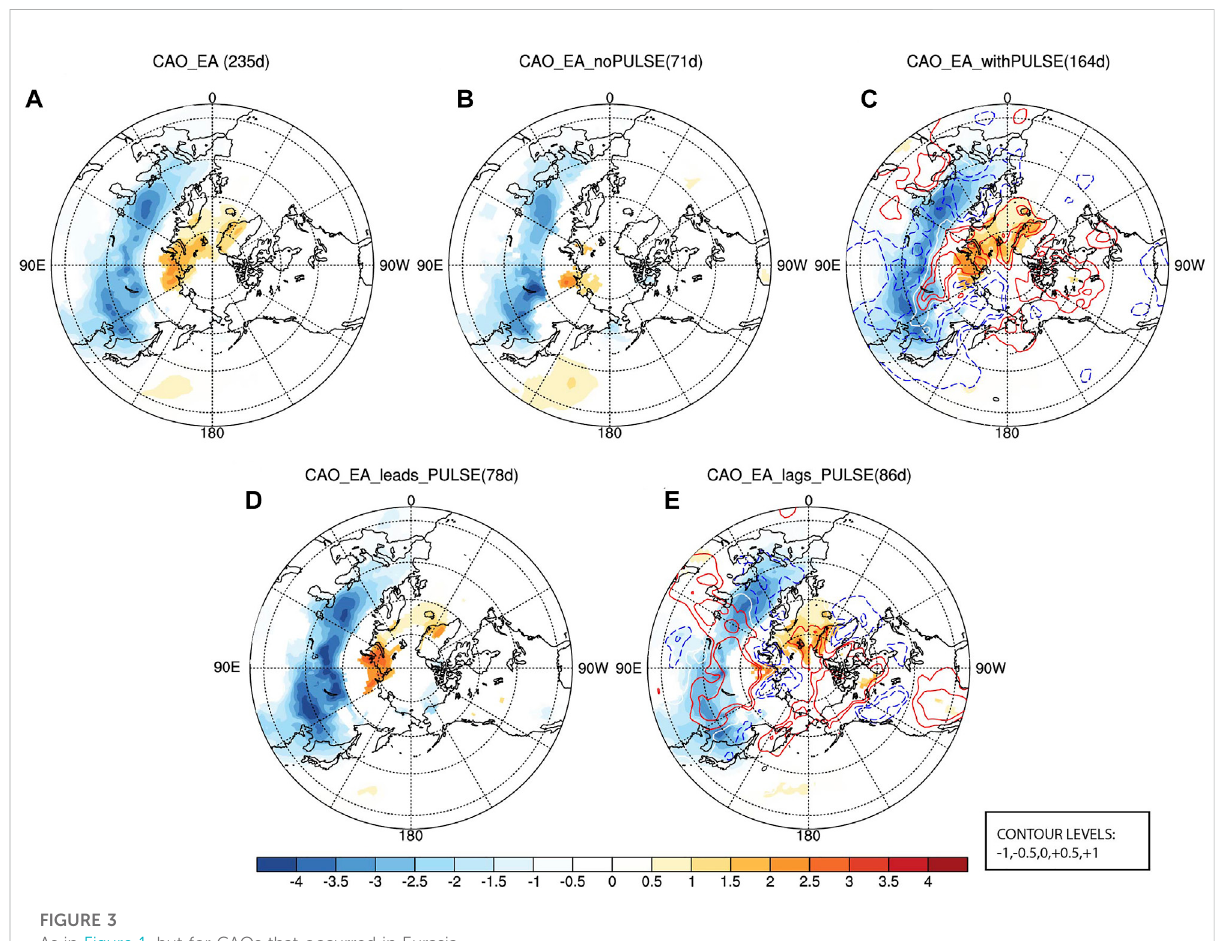
FIGURE 3 As in Figure 1, but for CAOs that occurred in